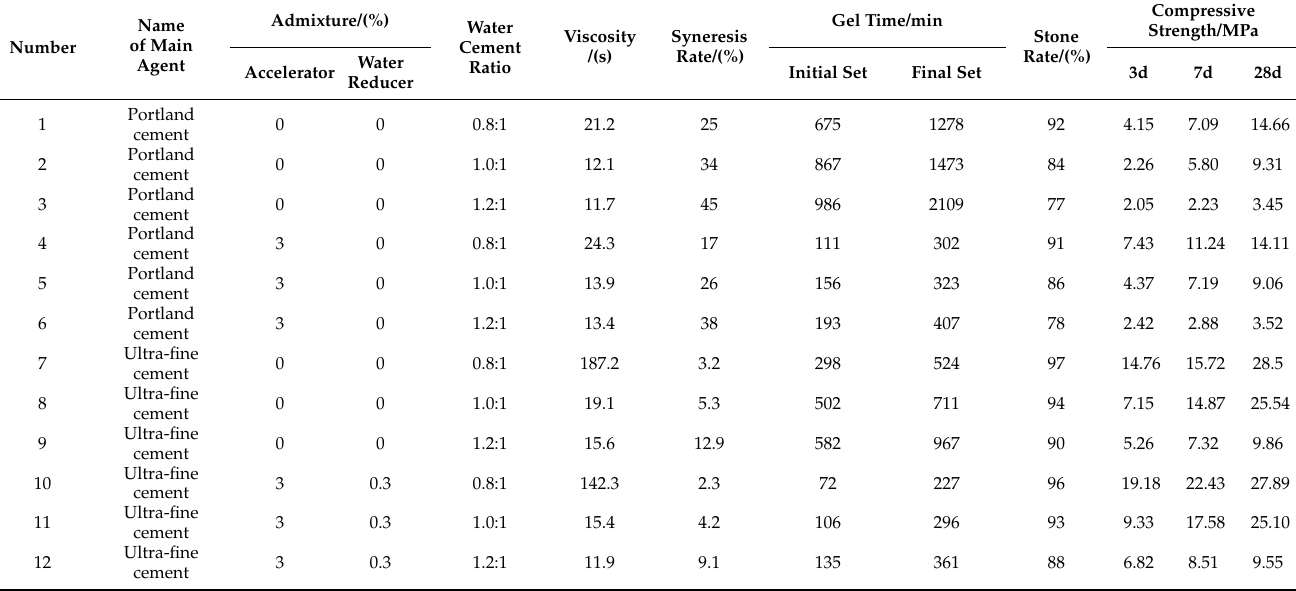
Table 2. Grouting material laboratory test